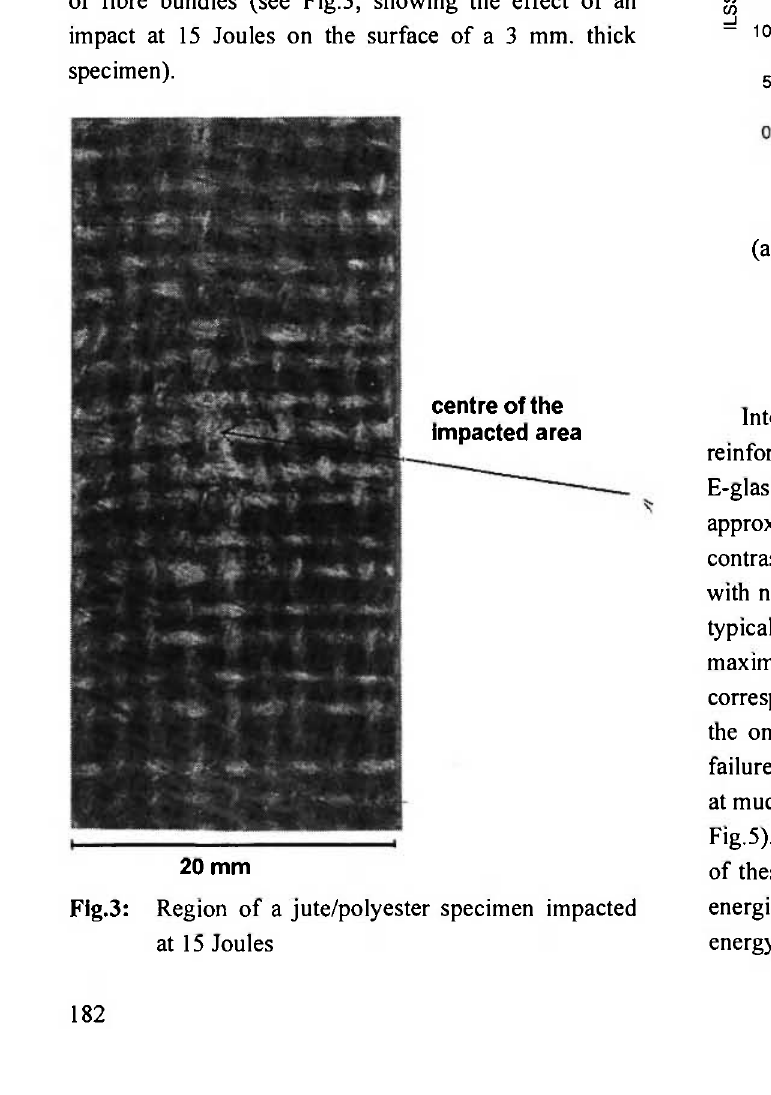
Fig.4: Interlaminar shear strength results (average and standard deviation on 20 samples)